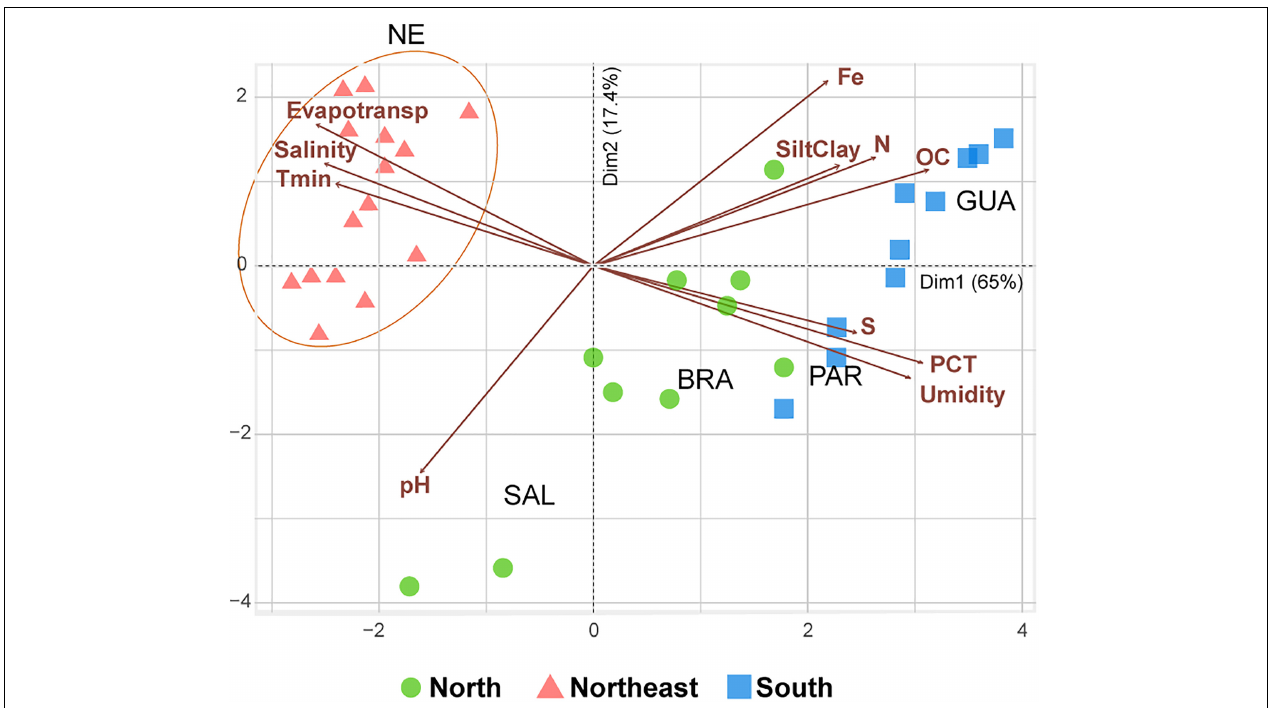
FIGURE 2 | Triplot diagram of the Principal component analysis (PCA) indicating the orientation pattern based on the variability of abiotic variables in the seven studied mangroves. The two first principal components are plotted with the proportion of variance explained by each component shown in parentheses in the axis titles. Abbreviated abiotic variables: Tmin (Minimum Temperature); PCT (Precipitation); Evapotrans (Potential Evapotranspiration); Fe (iron); N (Total Nitrogen); OC (Organic Carbon); SiltClay (Silt and Clay content); and S